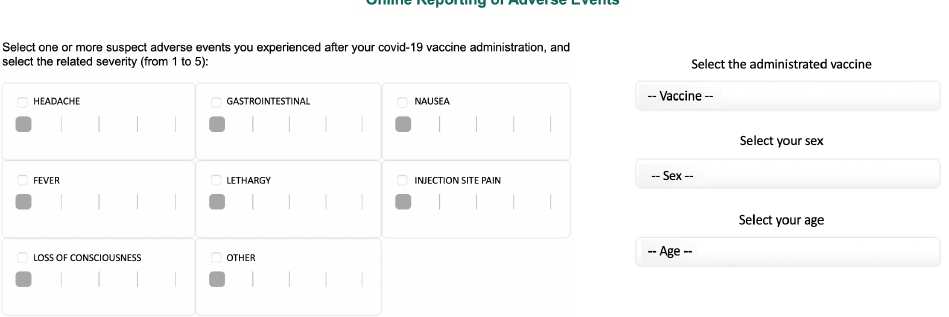
Figure 8. An example of online reporting of an adverse event on our